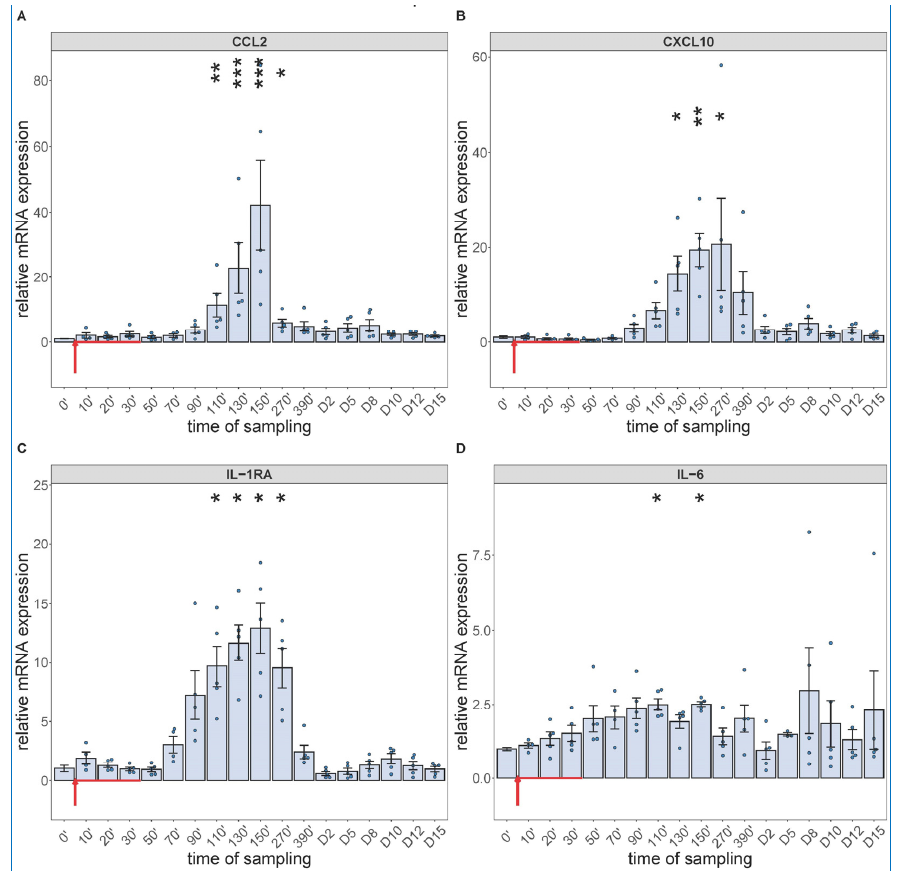
Figure 4. Gene expression of CCL2 ( A ), CXCL10 ( B ), IL-1RA ( C ) and IL-6 ( D ) were assessed from PBMCs isolated at different sampling times and normalized to 18S rRNA. Zymosan administration is marked with red arrow. Data are expressed as fold expression relative to a baseline control sample (0 min.). Kruskal–Wallis test with Dunn’s multiple comparisons post-hoc test, compared to respective baseline (0’) controls, * p < 0.05 vs. 0’; ** p < 0.01 vs. 0’; *** p < 0.001 vs. 0’. The cytokine protein assays performed for IL-6 and others (whose mRNA expression were not analyzed, i.e., TNF-alpha, IL-8 and IL-1beta) confirmed the early expression of IL-6 but showed the production of TNF- α to be even faster and more intense, peaking about 30 min earlier at about 10-fold higher concentration than IL-6 (Figure 5A,B). The concentrations of IL-8 and IL-1beta tended to be increased in some animals after day 10, with substantial individual variation (Figure 5C,D).